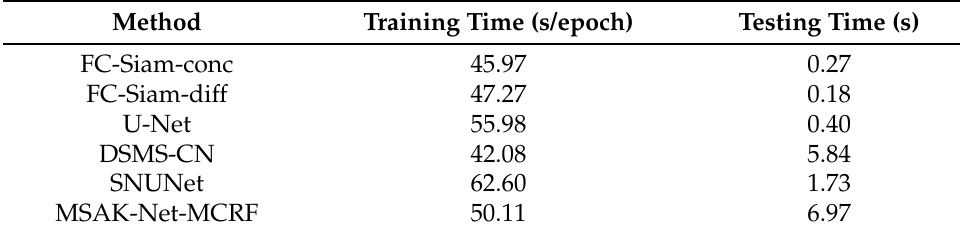
Table 6. Comparison of calculation time of six